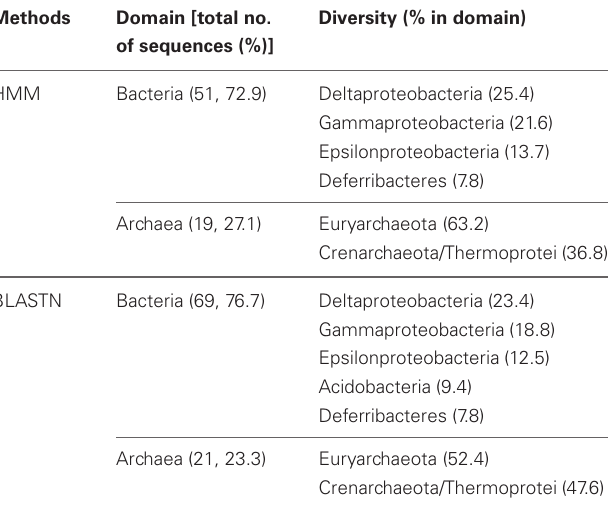
Table 2 | Taxonomic diversity based on 16S rRNA gene prediction from the